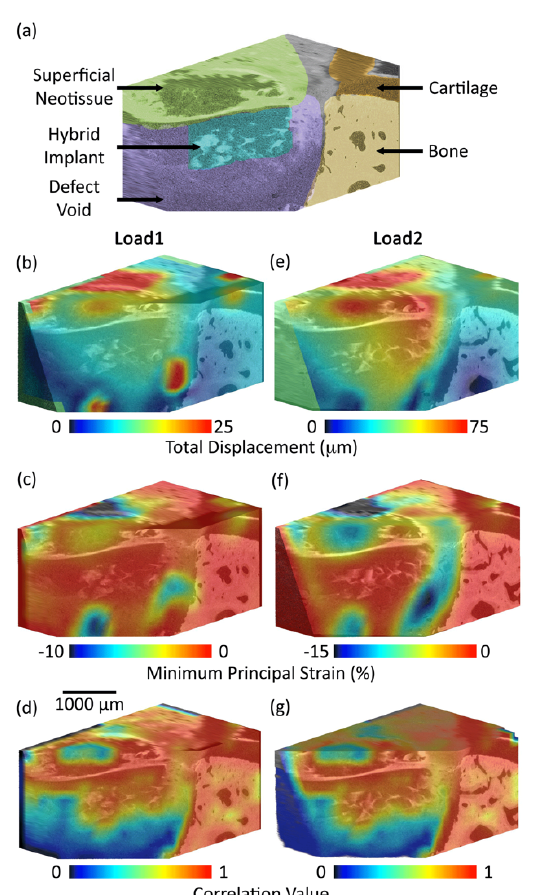
Figure 4. Micro-CT rendering with annotated colouring shows the system components ( a ). Combining three dimensional imaging with in situ mechanical testing and DVC enabled visualisation of local displacement ( b , e ) and strain ( c , f ) for each component of the system ( a ) at two levels of compressive loading; also presented is the correlation value across the system components ( d , g ): 0 = no correlation 1 = perfect correlation.